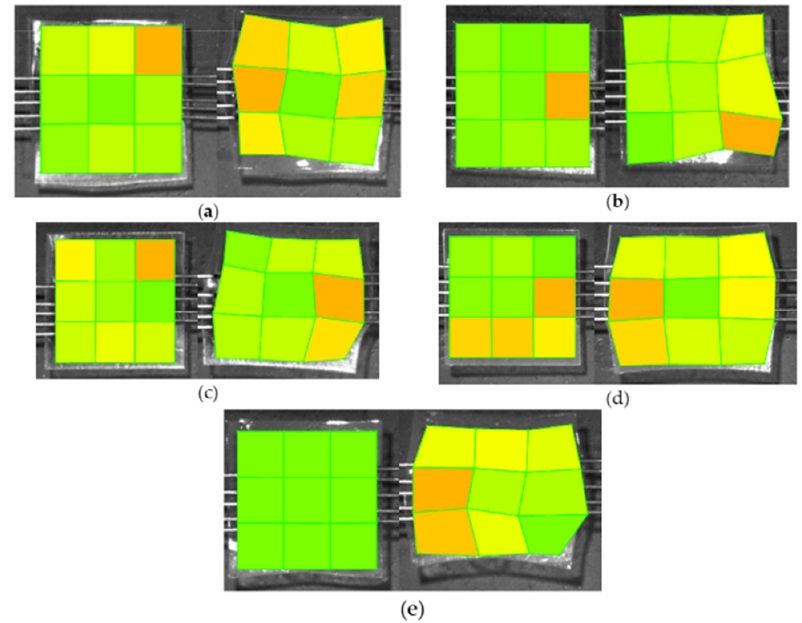
Figure 6. Images show the strain patterns (low strain—green; high strain—orange) before any applied stress (Left) and after the stress test has completed (Right). ( a ) 50% w/w glycerol (ruptured); ( b ) Eudragit control film (ruptured); ( c ) 50% w/w DOP; ( d ) 50% w/w [HMIM]Cl; ( e ) 50% w/w blend. Images with source points were generated using the LabJoy software interface accompanying the BioTester equipment.